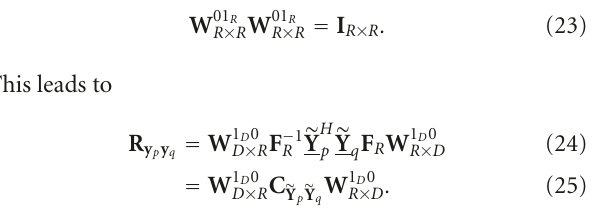
The operator Diag { a } denotes a square matrix with the ele- ments of vector a on its main diagonal. An illustration of